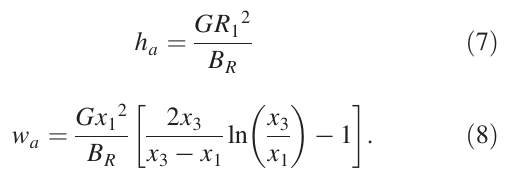
FIG. 1. H-type hybrid PM quadrupole design.